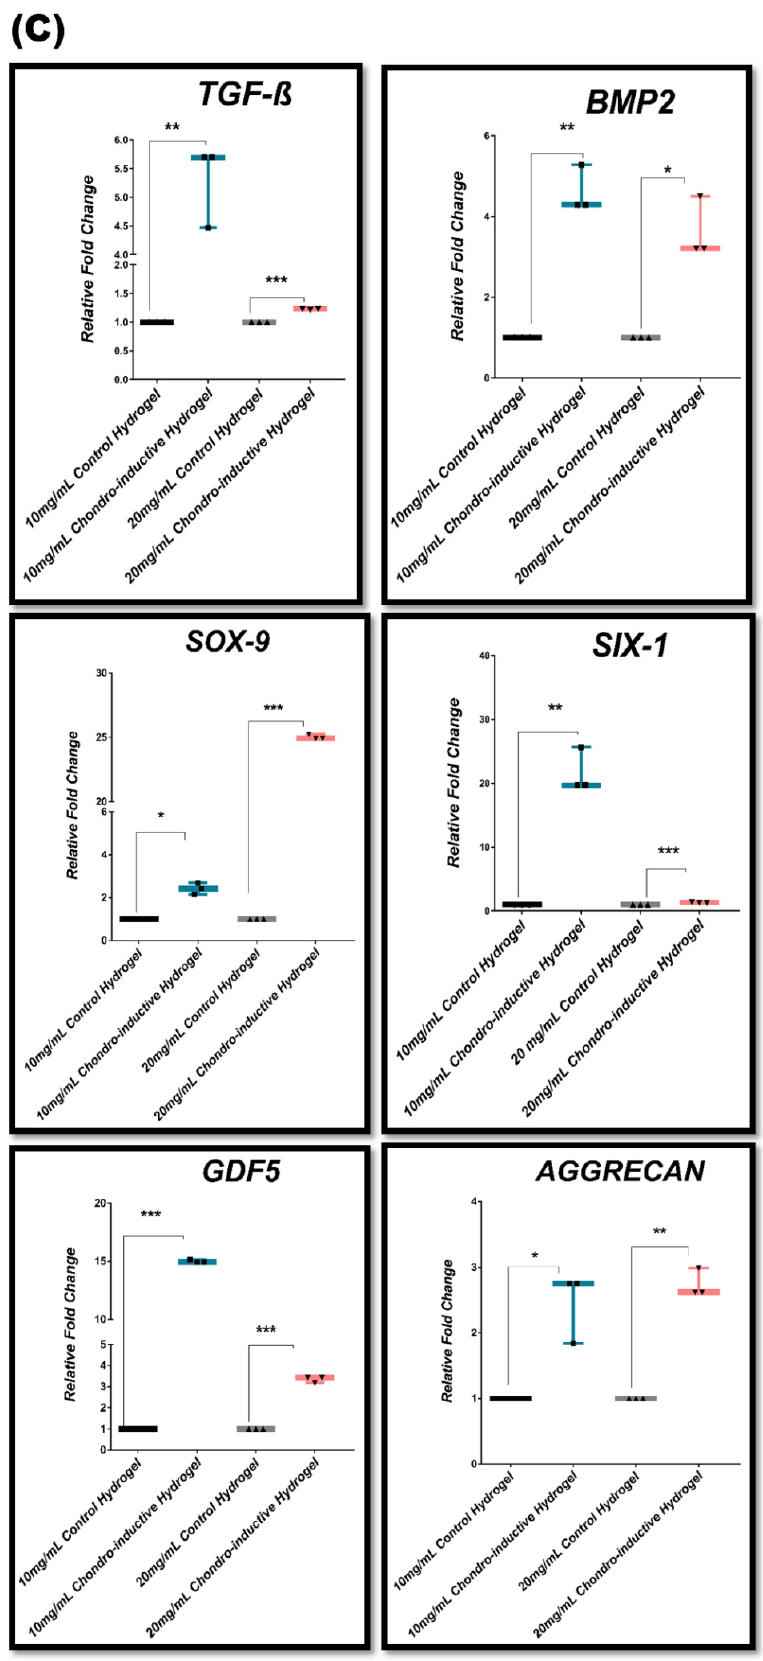
Figure 7. Gene expression profile of chondrogenic markers in 3D hydrogel-cultured MSCs: ( A ) Bar graphs representing quantitative 2-fold (2 − ∆∆ CT ) changes in chondrogenic genes TGF- β